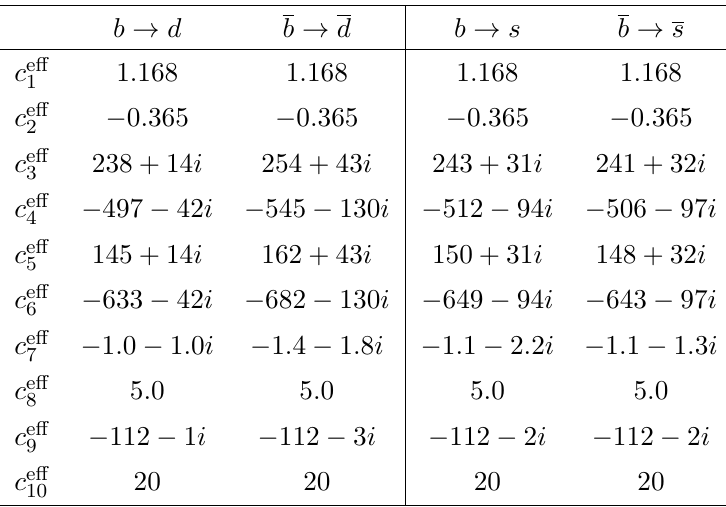
Table 2 . The effective Wilson coefficients with the NDR and MS schemes at the energy scale of and c eff are in the units of 10 0 and 10 − 4 , respectively. µ = 2 . 5 GeV, where c eff 1 , 2 3 − 10 f 1 q 2 = m 2 ρ q 2 = m 2 K